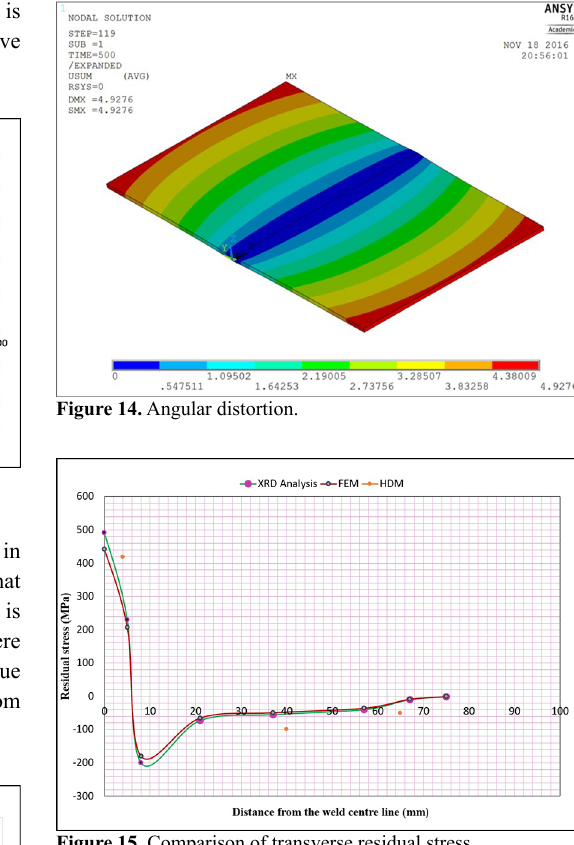
Figure 15. Comparison of transverse residual